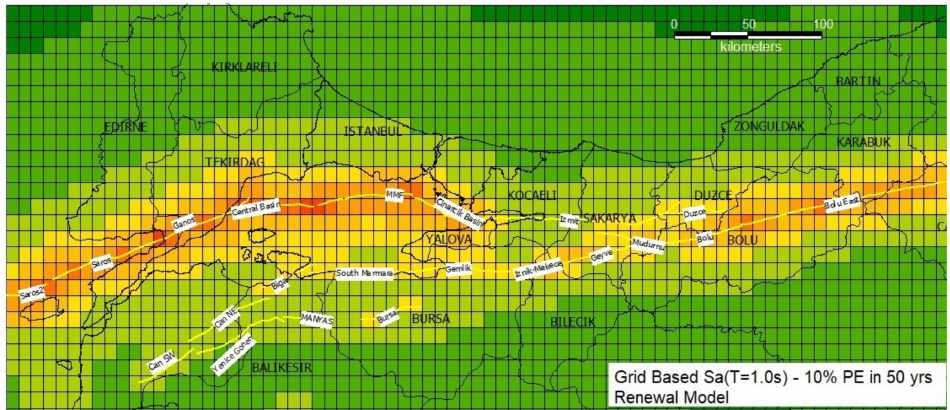
Figure 22. Grid-based SA (T = 1.0 s) distribution at NEHRP B / C boundary site class for 10% (upper panel) and 2% (lower panel) probabilities of exceedance in 50 years (Renewal model). Color coding is the same as in Figure